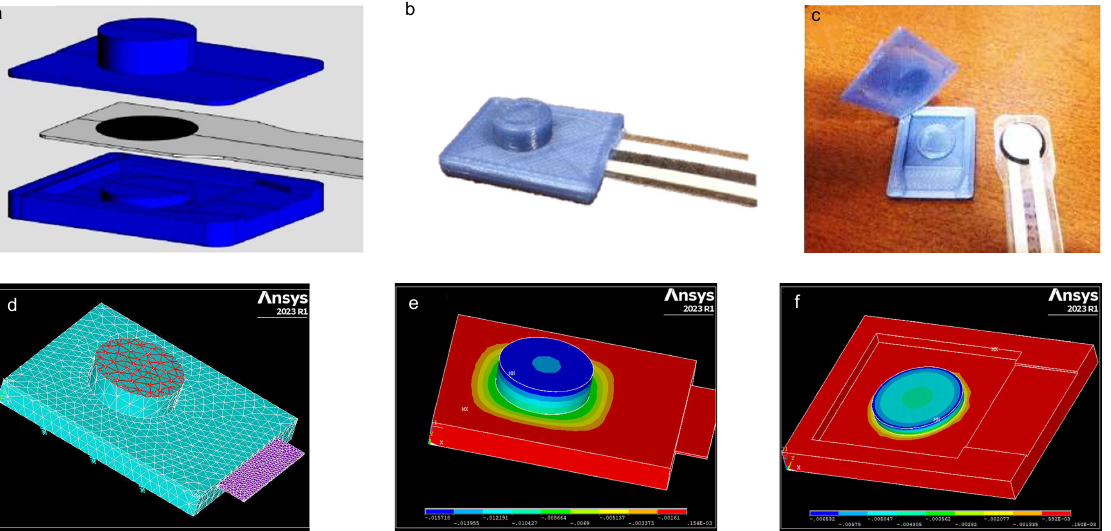
Figure 1. ( a ) 3D model of the housing realized with Rhinoceros 7 software. Note how the film sensor (in grey) is positioned over the bottom part of the housing before the upper part is printed on top; ( b ) example of housed sensor; ( c ) upper and lower sides of the housing have been separated with a cutter to show inner side. The material in this example is PLA. At the bottom, a finite-element model simulation of the elastic deformation of the housing exposed to a 400 N load is shown; ( d ) definition of the mesh; ( e ) deformation of the external upper surface; ( f ) deformation of the inner inferior surface (blue = highest; red = lowest). Note that the load is transmitted to the lower layer exclusively through the circular cantilevered area corresponding to the sensing area of the transducer. The FEM model of the housing has been realized with Ansys 2023 R1